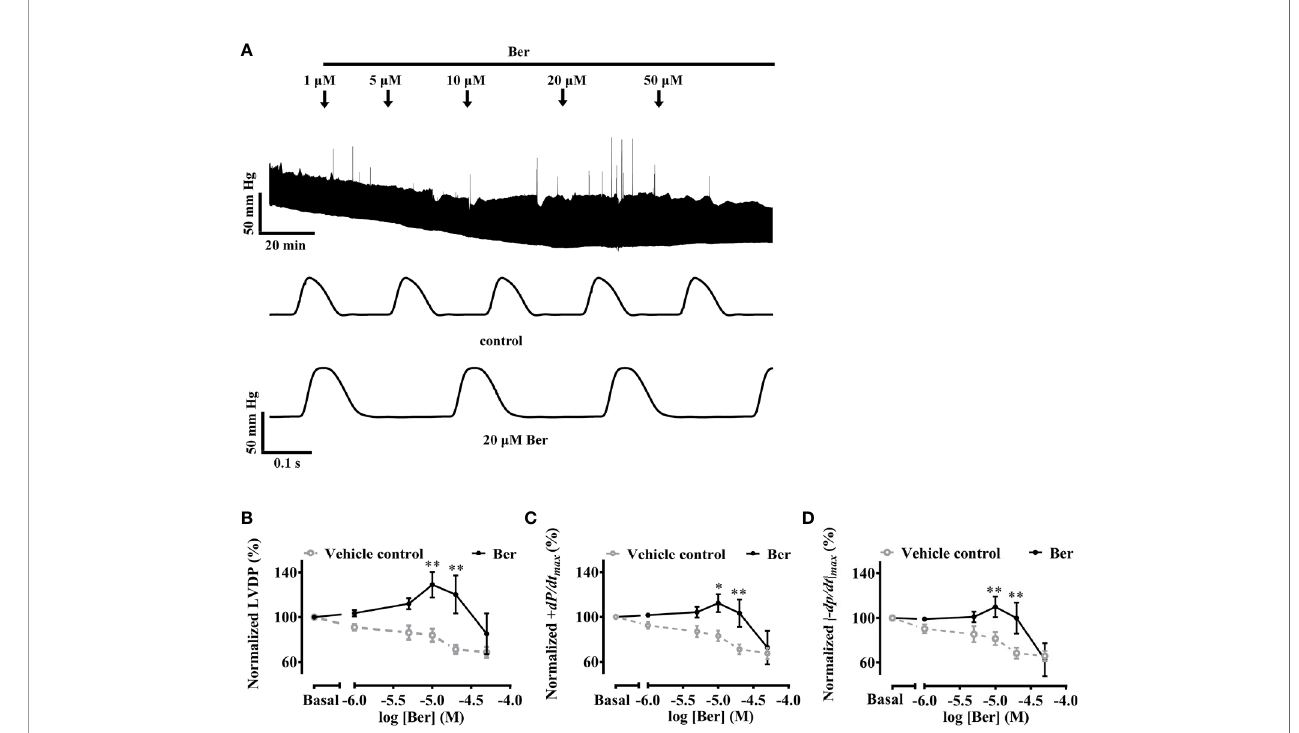
FIGURE 1 | Berberine increased the capability of Langendorff-perfused isolated rat hearts for contraction. (A) An original recording showing that the effect of berberine on left ventricular pressure (LVP) of an isolated rat heart. (B – D) Summary data showing the effects of berberine on LVDP, + dp/dt max and | − dp/dt | max , respectively. The numbers of repeats are as follows: vehicle control group, N = 6; Ber-treated group, N = 6; N is the number of rats. Ber stands for berberine. * p < 0.05, ** p < 0.01 vs. vehicle control group; two-way ANOVA with Sidak's multiple comparisons